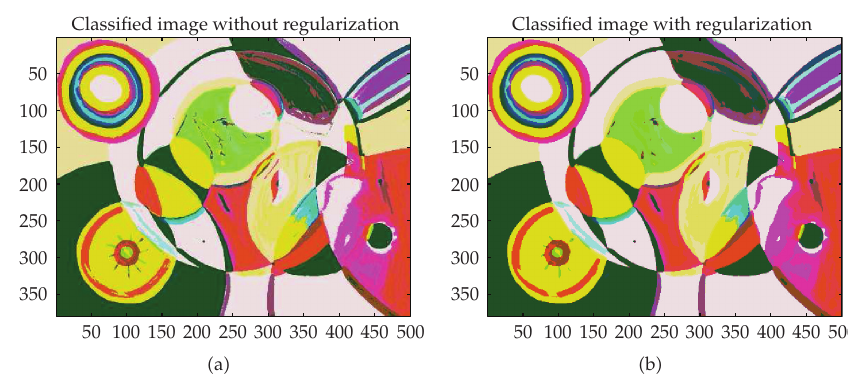
Figure 5: From (cid:7) a (cid:8) The unregularized classified image and and (cid:7) b (cid:8) the regularized classified